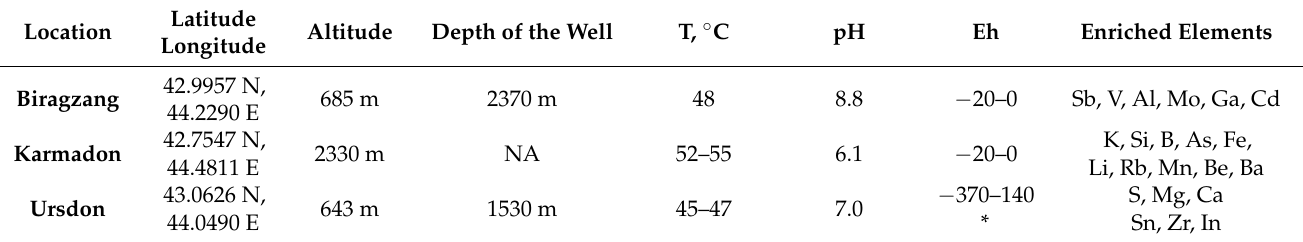
Figure 1. Map and photographs of sampling sites of the Republic of North Ossetia-Alania. ( A ) Map at region scale; ( B ) map at continent scale, active volcanoes indicated by black triangles; ( C ) part of natural travertine-formed thermal bath at Karmadon spring #4135; ( D ) sediment under the thermal water outlet at Biragzang deep well; ( E ) hydrosulfide-rich puddle formed as a result of thermal water pipe seepage near the Ursdon well outlet. Table 1. Physicochemical characteristics of North Ossetian geothermal habitats.